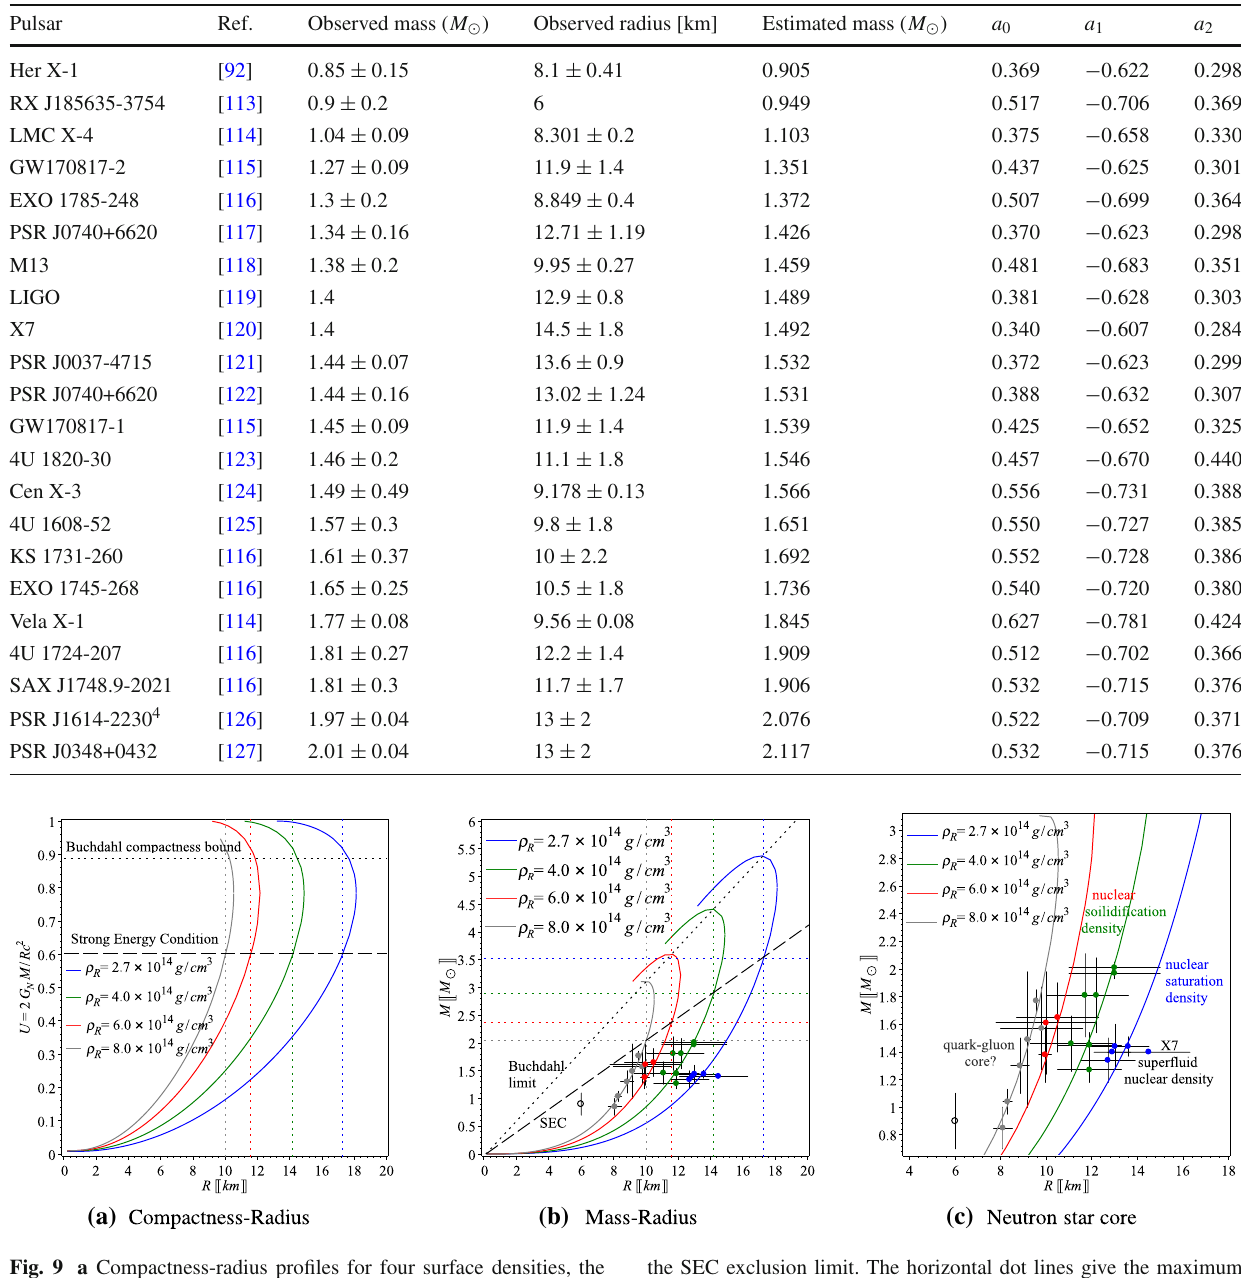
the SEC exclusion limit. The horizontal dot lines give the maximum possible mass as obtained by the SEC. c Pulsars on the red, green and blue mass-radius profiles are suggested to have neutron cores whereas the surface densities match superfluid, saturated, solidified nuclear den- sities. The pulsars on the gray mass-radius profile match perfectly a surface density boundary condition ρ R = 8 × 10 14 g/cm 3 which may suggest quark-gluon cores for those